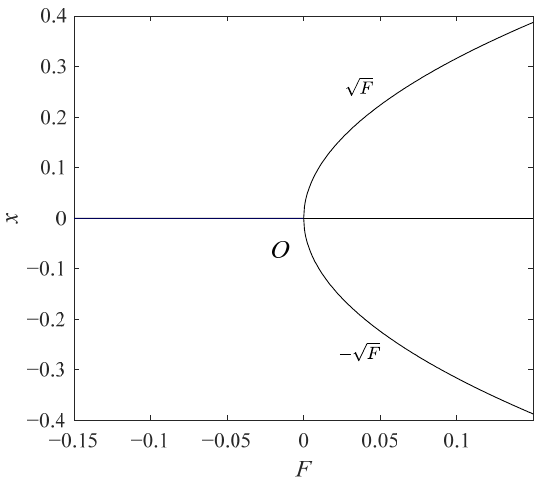
Figure 1. Pitchfork bifurcation of Equation (3).